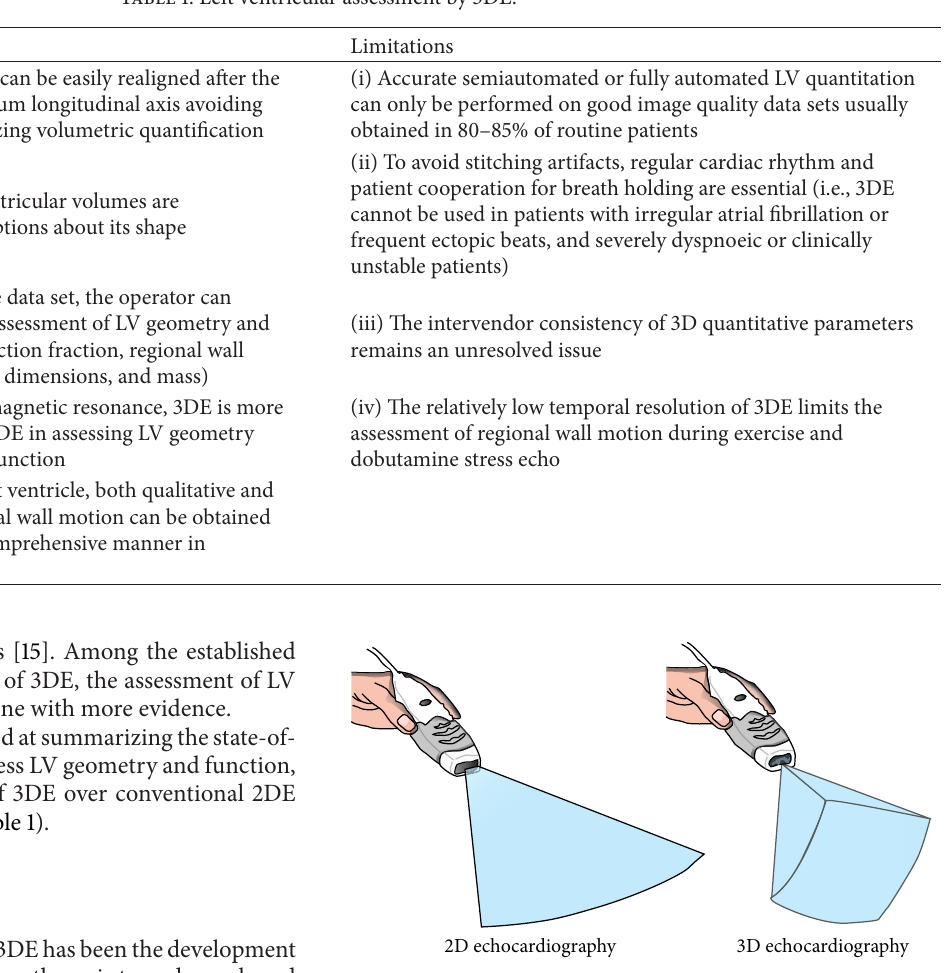
Table 1: Left ventricular assessment by 3DE.